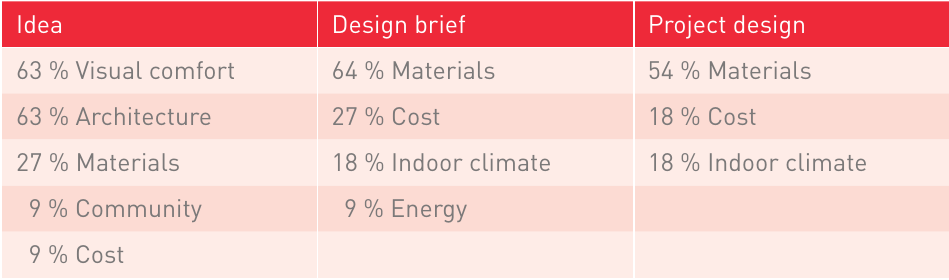
Percentages denotes the frequency of specific parameters mentioned by architect and